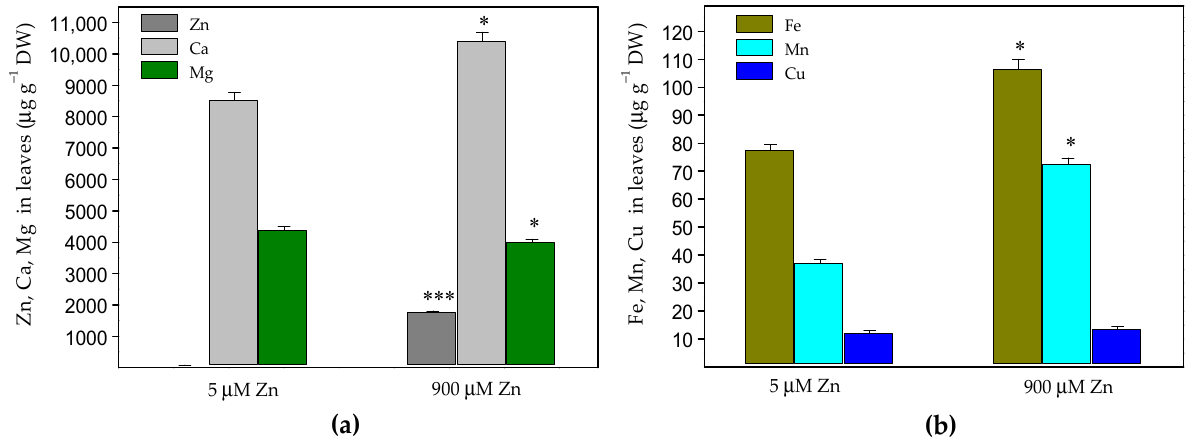
Figure 2. Contents of Zn, Ca and Mg ( a ) and Fe, Mn and Cu ( b ) in Salvia sclarea leaves (µg g − 1 DW) after 8 days of exposure at 5 µM (control) or 900 µM (excess) Zn. Mean values (±SE) were compared between the two Zn exposures for the same mineral elements using a Student’s t -test, and the differences were considered statistically significant with * p < 0.05 or *** p < 0.001.